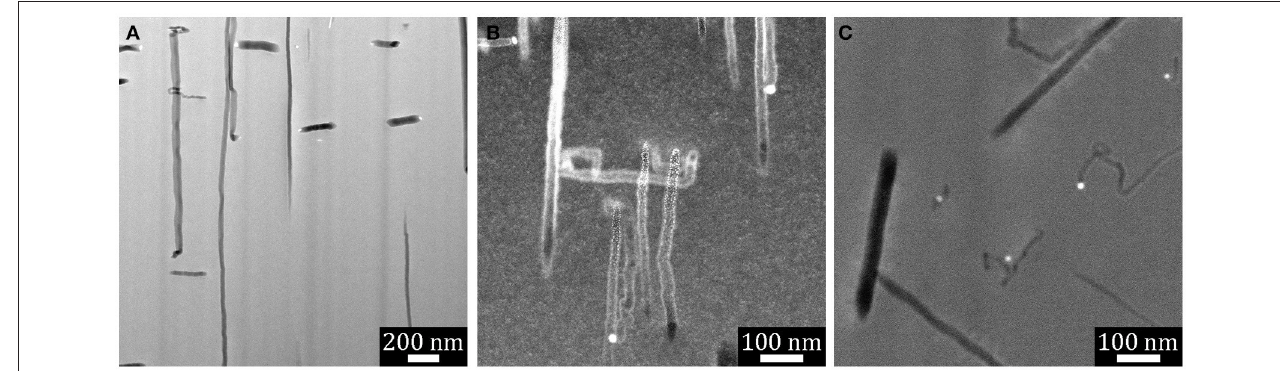
FIGURE 3 | HAADF STEM images of FIB-cut cross-sections taken from the walls of macropores on Si substrates that had been subjected to Ag-catalyzed metal assisted etching in H 2 O 2 + HF solution: (A) Si(001), (B) Si(110), (C)